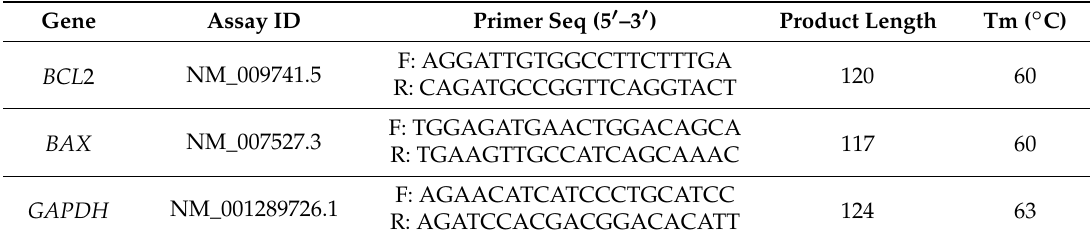
Table 2. PCR primers used for SYBR green Q-PCR